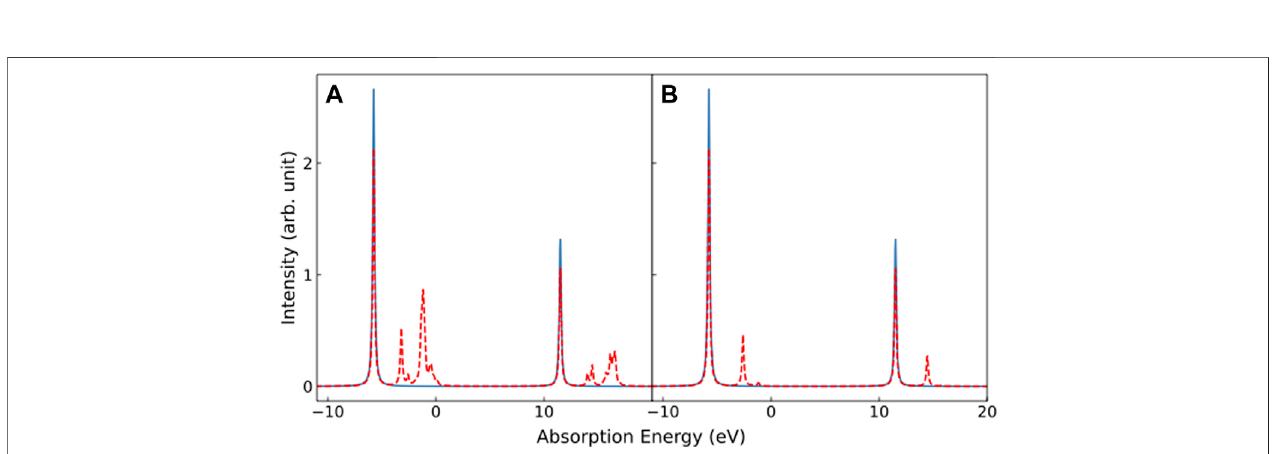
FIGURE 4 | XAS spectra for the undoped d 9 ion (solid line) and with 20% of the hole-doped d 8 ion (dashed line) calculated for x -polarization. Panel (A) shows the results for doping with the d 8 high-spin state, and panel (B) shows the results for doping with the d 8 low-spin state.